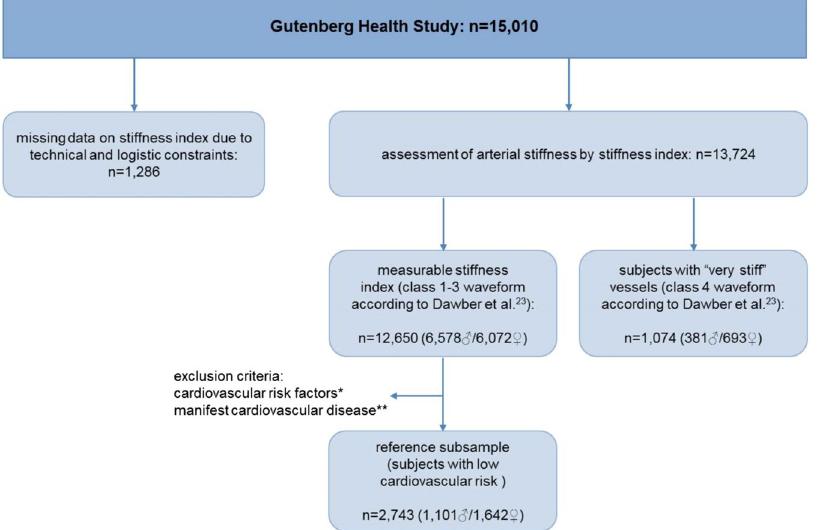
Figure 1. Study Design. * Cardiovascular risk factors: hypertension, obesity, dyslipidemia, smoking, diabetes, family history of myocardial infarction or stroke. ** Manifest cardiovascular disease: history of myocardial infarction, coronary artery disease, congestive heart failure, stroke or peripheral artery